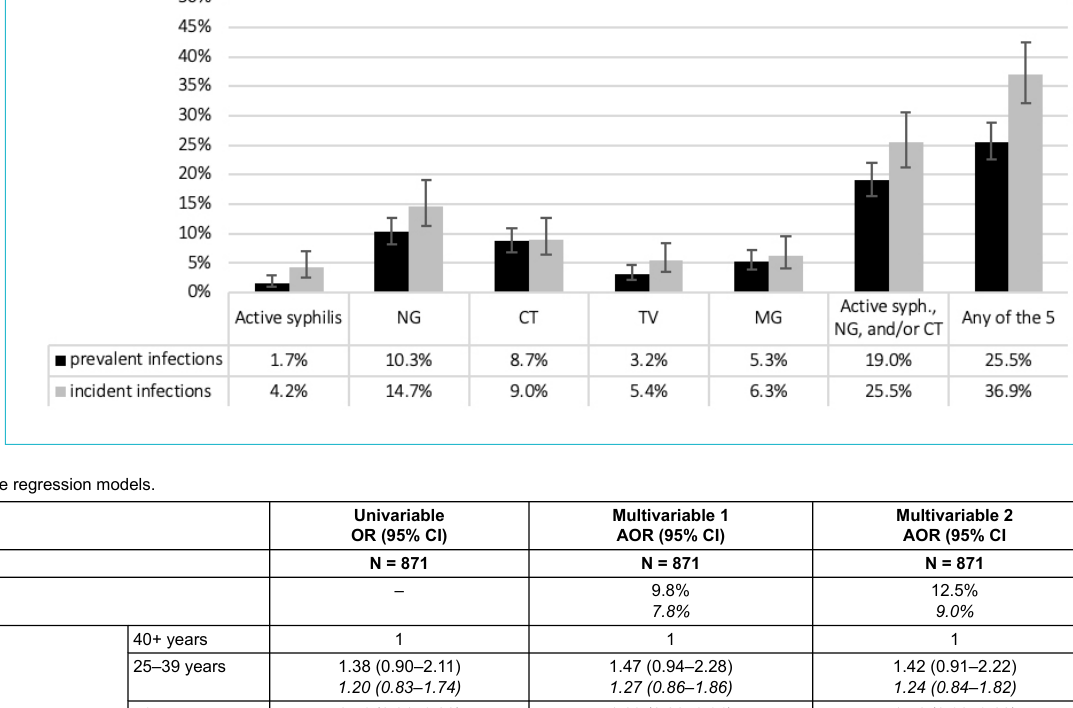
Figure 1: Sexually transmitted infections among men who have sex with men at baseline (n = 779) and during follow-up (n = 526 over 623 fol- low-up visits; 333.2 years of follow-up); percent with 95% confidence intervals. CT = C. trachomatis ; MG = M. genitalium ; NG = N. gonor- rhoeae ; TV = T. vaginalis .